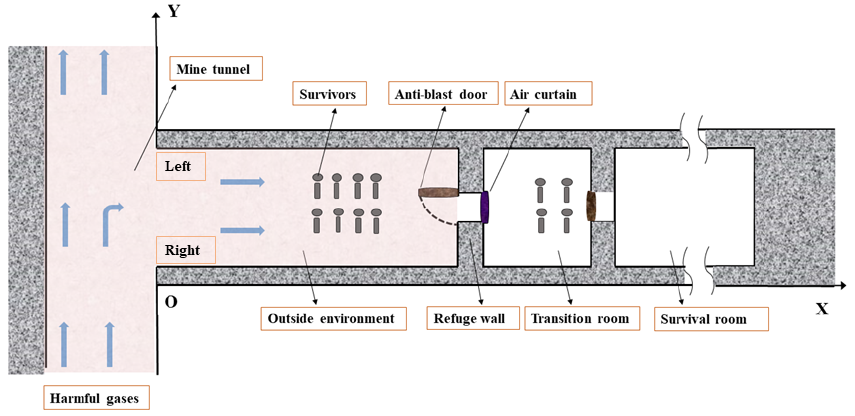
Figure 2. Refuge space division.